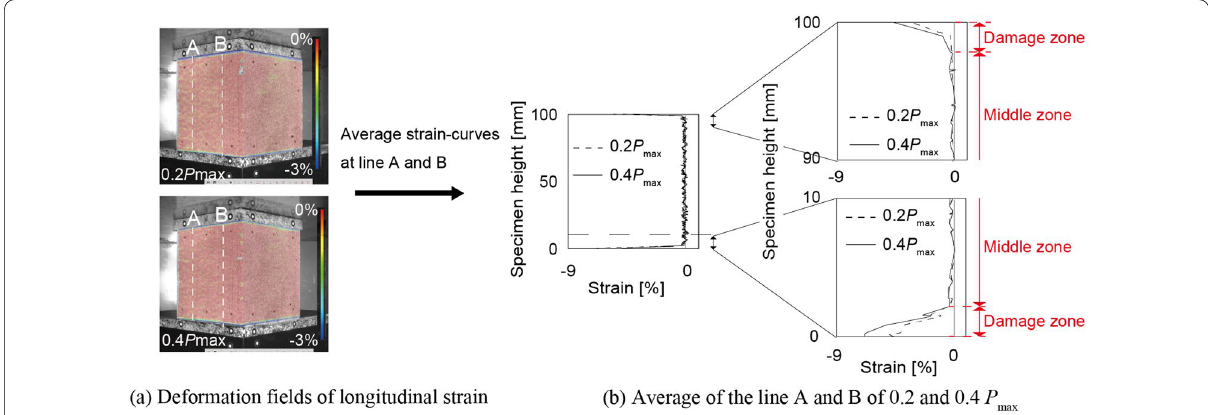
Fig. 9 Longitudinal strains of specimen 10-1Ce at 0.2 and 0.4 P max by